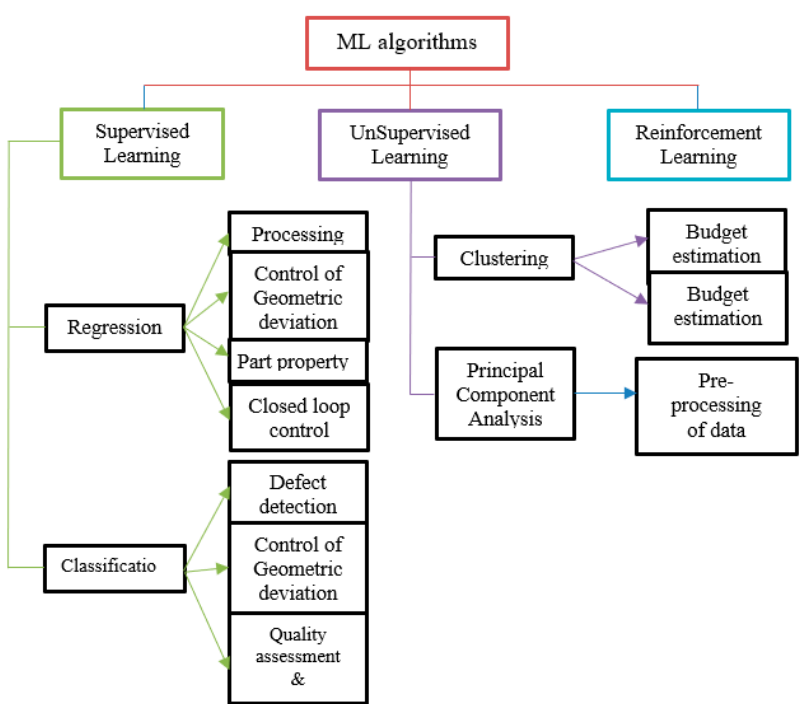
Figure 30. A classification scheme of machine learning algorithms based on their operating principle.